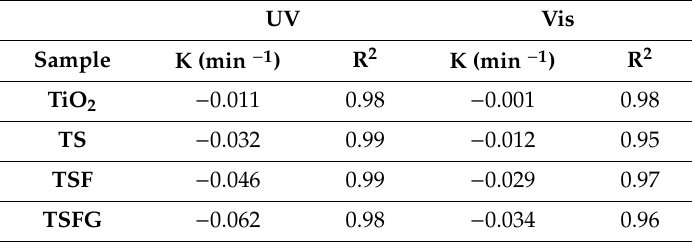
Table 3. The kinetic constants of photocatalytic MB degradation under UV and Vis